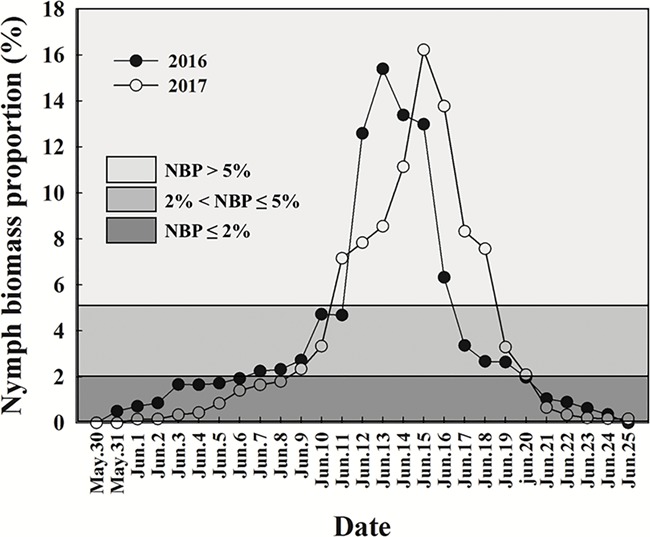
Temporal trend in grasshopper nymph biomass at Hulun lake nature reserve in 2016 and 2017. NBP is the percentage of the daily nymph biomass relative to the total biomass measured over all survey days. NBP > 5%, 2% < NBP ≤ 5% and NBP ≤ 2% represent high, medium and low nymph biomass, respectively.